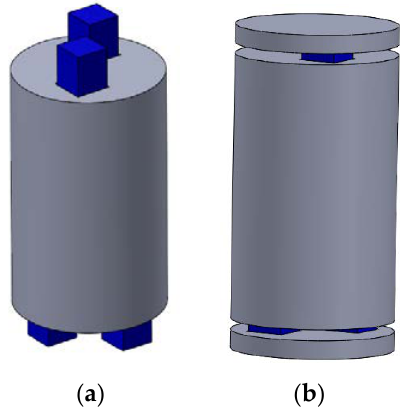
Figure 2. Fabrication of high-authority piezoelectric actuator (HAPA) by ( a ) inserting and bonding 4 piezoelectric stacks (marked blue) at the recess bases of a (2 + 2)-HBSC, and ( b ) further bonding the top and bottom end caps to complete the construction. The wiring is not shown for clarity sake.